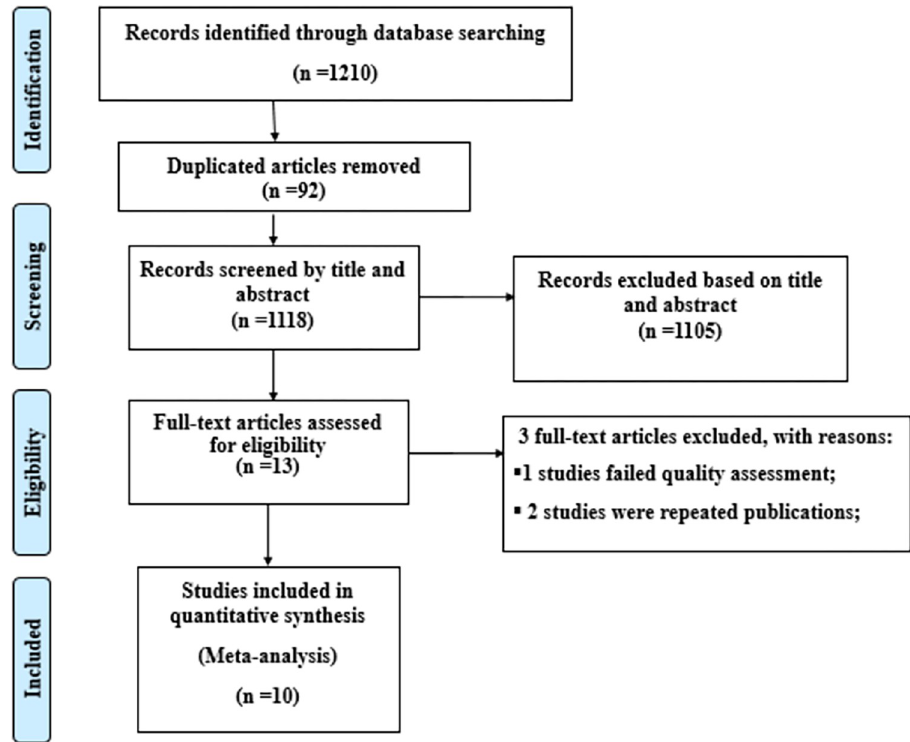
Fig 1. PRISMA flow diagram of the included studies for the systematic review and meta-analysis of induced abortion among female students at higher education institutions in Ethiopia.